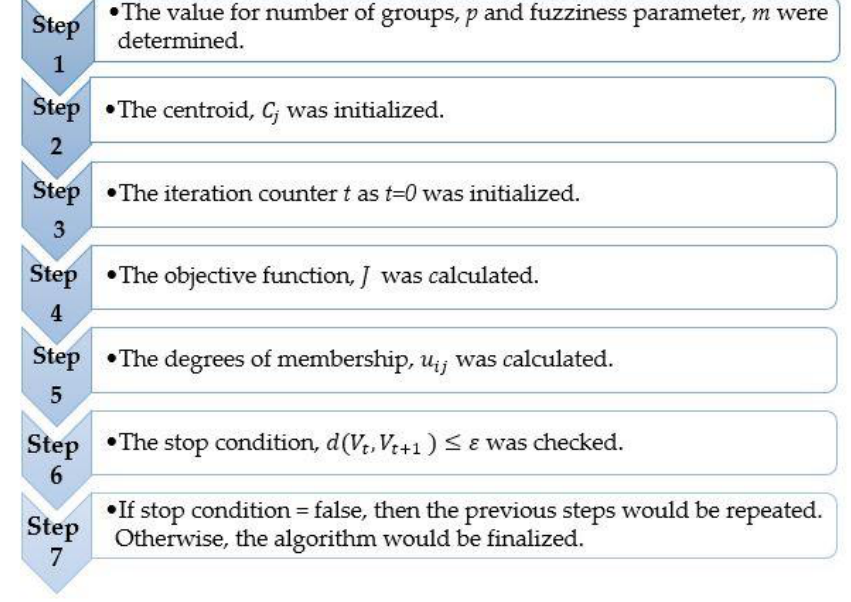
Figure 3. Procedure of